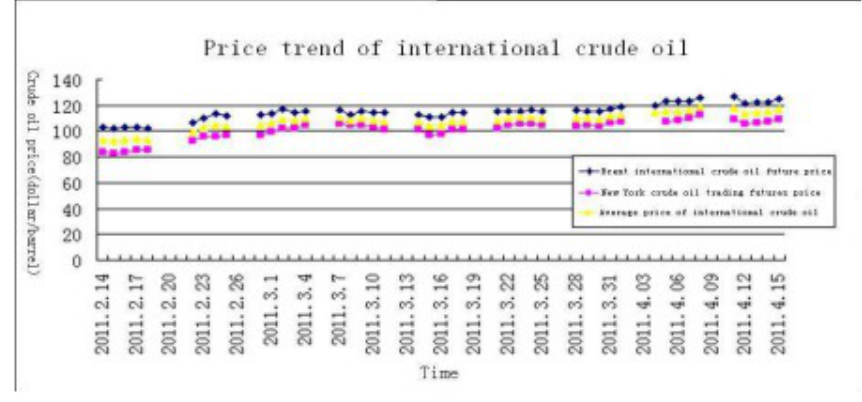
Figure 2. Chart of international crude oil price around Japan’s earthquake (Data source: United States Department of Energy: